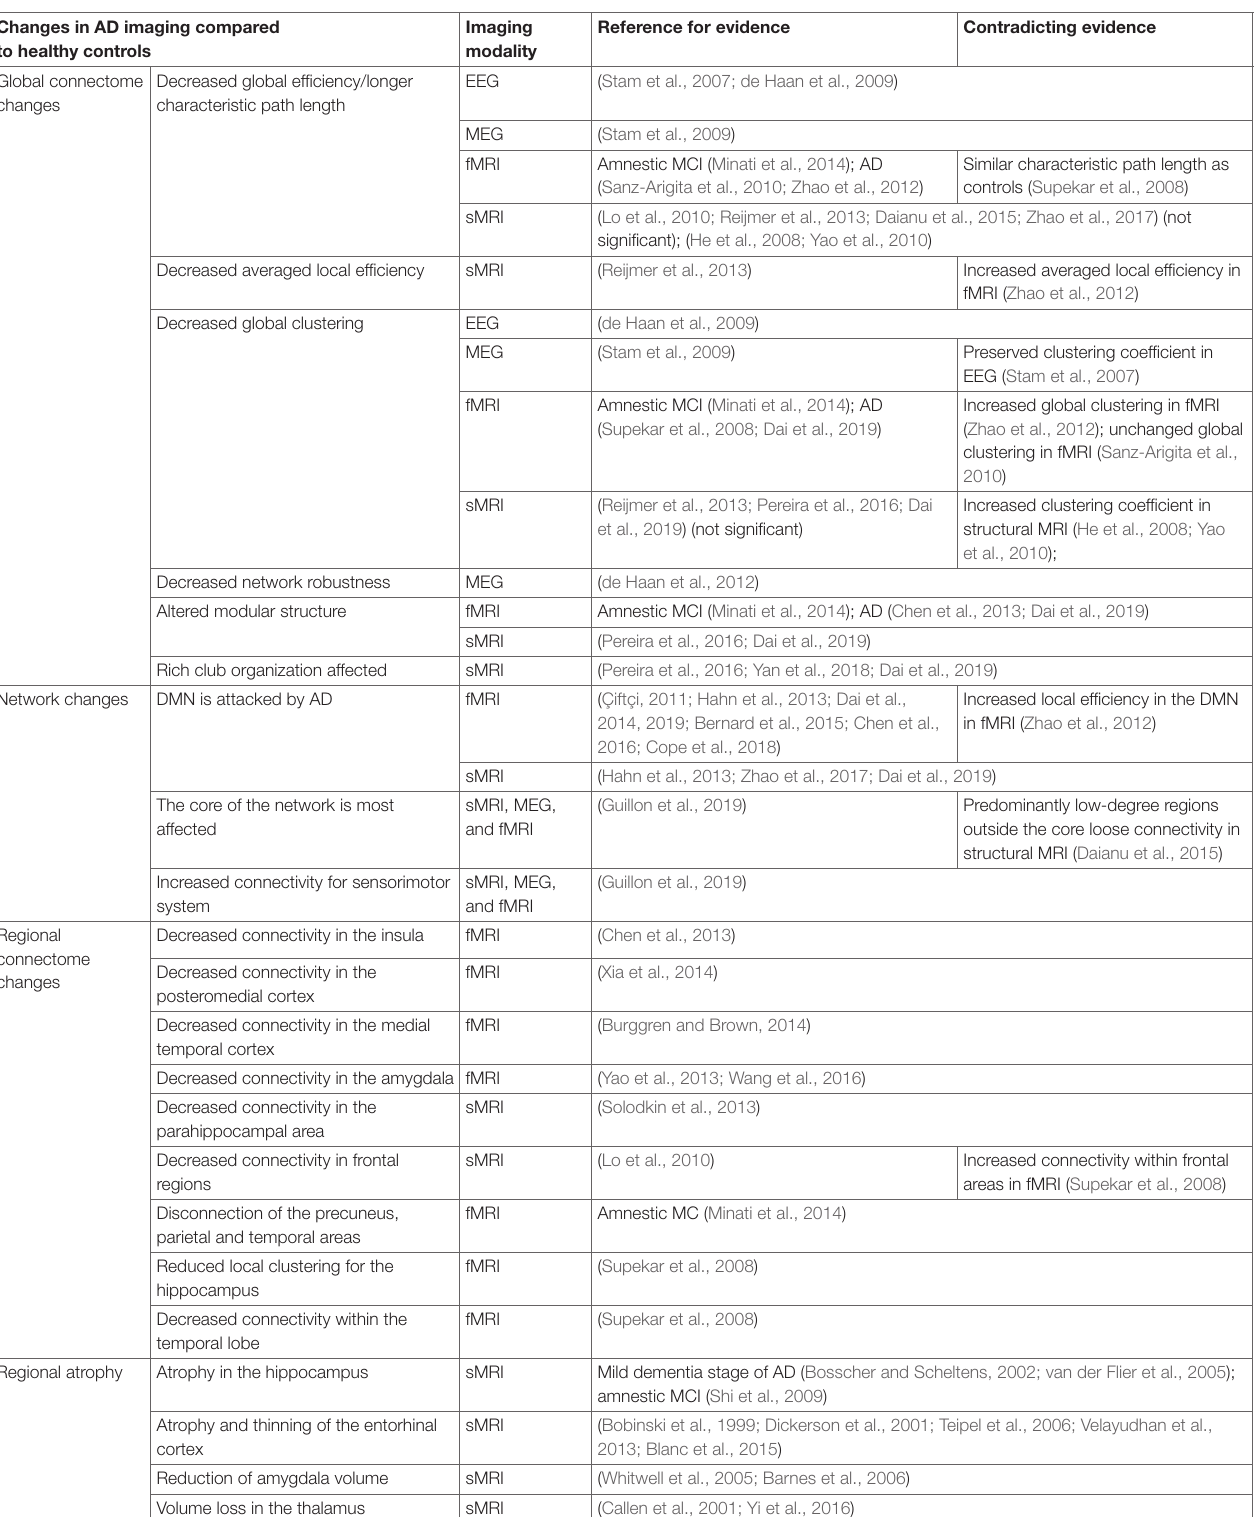
Imaging Reference for evidence Contradicting evidence modality